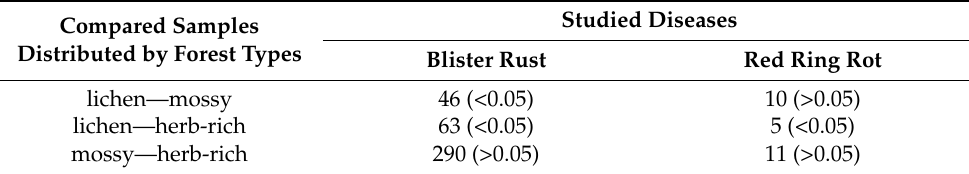
Table 3. Disease incidence assessment in pine forests (the Mann–Whitney U test ( p -value)). Compared Samples Distrib-